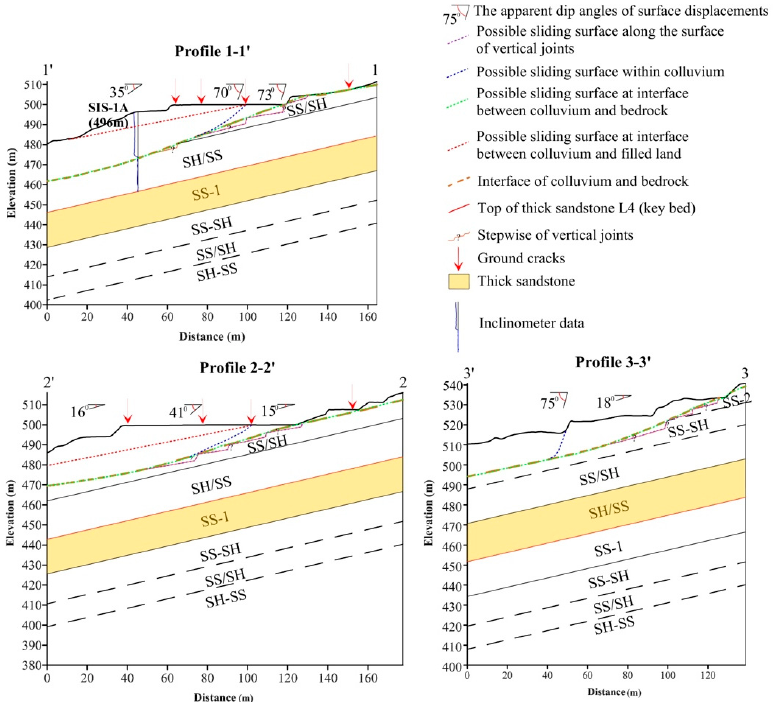
Figure 15. Geometry of each sliding block in the northwestern part (group 1) shown using stereonets. Each stereonet illustrates a block in motion, with the green dots representing the head and the orange ones representing the main body to the toe of the sliding mass. The hollow triangles on the stereonets represent the dip direction of the orange solid circles, with respect to the two surface displacements bordered by black circles in the southwest portion of the map view. The contour line interval for the colluvium–bedrock interface is 1 m.